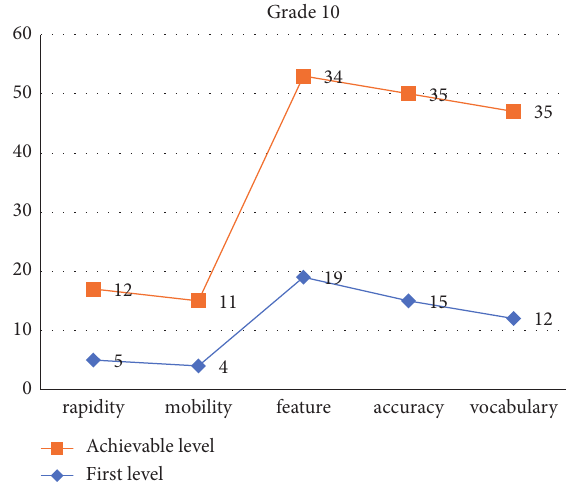
Figure 9: Achieved level of creativity and communicative com- petence of grade 11